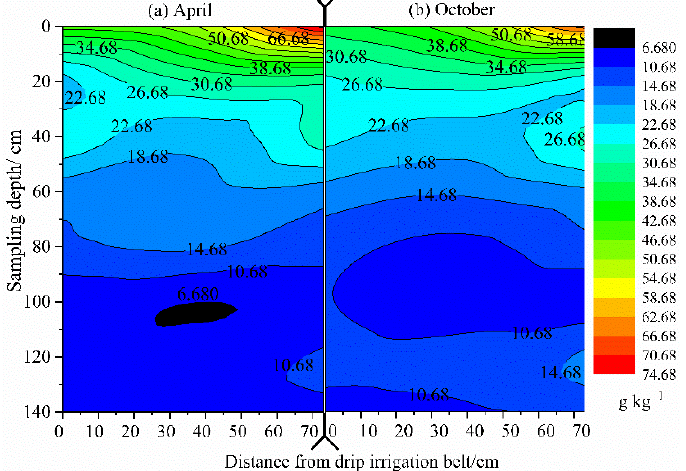
Figure 3. Salt distribution in 0–140 cm soil layer from drip irrigation belt to bare land between the mulching films in the first year of MDI.